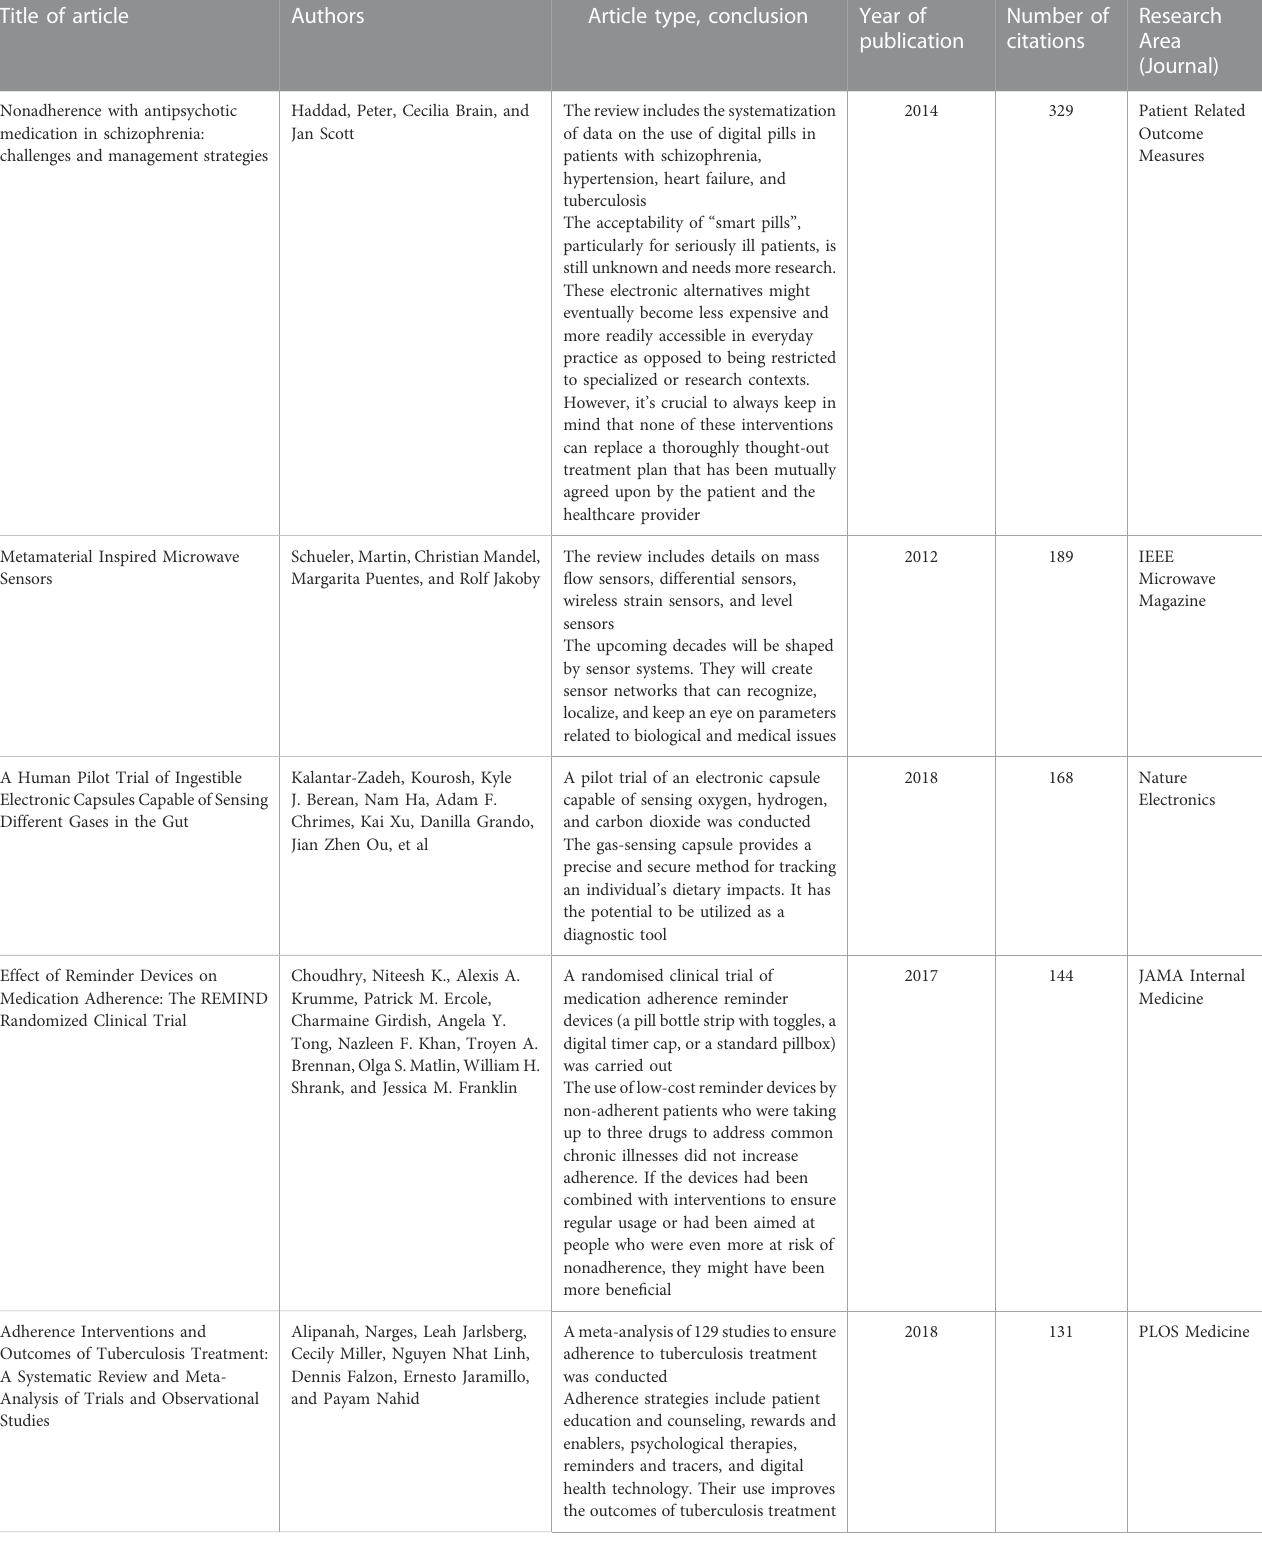
TABLE 6 The Top fi ve most cited publications for the period January 2012 to July